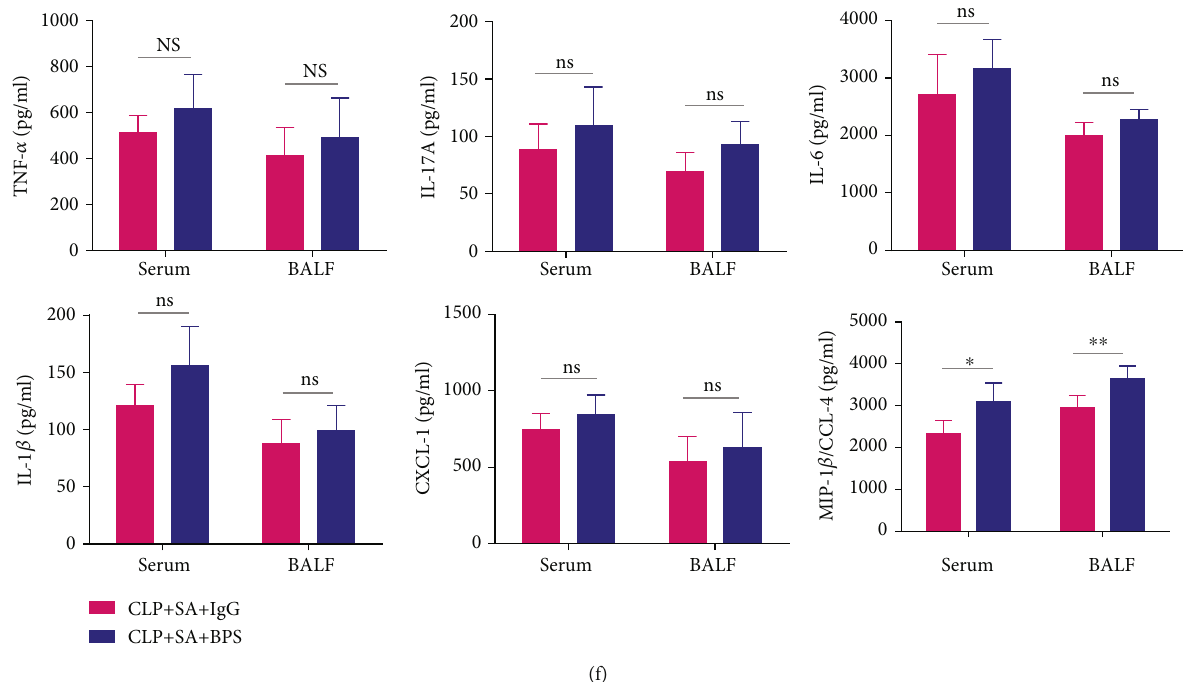
Figure 3: Postseptic basil polysaccharide is resistant to S. aureus pneumonia. (a) Survival of mice treated with basil polysaccharide upon S. aureus infection during sepsis ( n = 15 mice/group). (b) Typical HE staining for lung tissue samples at 24h postinfection with S. aureus during sepsis and following treatment with IgG or basil polysaccharide group. (c) Histological scores for secondary pulmonary infection with S. aureus within septic mice, as well as following treatment with IgG or basil polysaccharide ( n = 5 mice/group). (d, e) TUNEL assay was performed to determine cell apoptosis, where the nuclei of TUNEL-positive cells were dark-brown. (f) BALF and serum cytokine or chemokine contents were detected at 24 h after treatment with IgG or basil polysaccharide during sepsis-induced secondary S. aureus pneumonia in mice. Specimens were collected for analysis by Mice Cytokine Magnetic Bead Panel Kit ( n = 5 mice/group). Survival curves were analyzed using the log-rank (Mantel-Cox) test. Data were expressed as mean ± SD , whereas nonparametric Mann – Whitney U test was applied for data analysis. ∗ p < 0 : 05 , ∗∗ p < 0 : 01 , and ∗∗∗ p < 0 : 001 , relative to secondary pulmonary infection with S. aureus of septic mice in the IgG